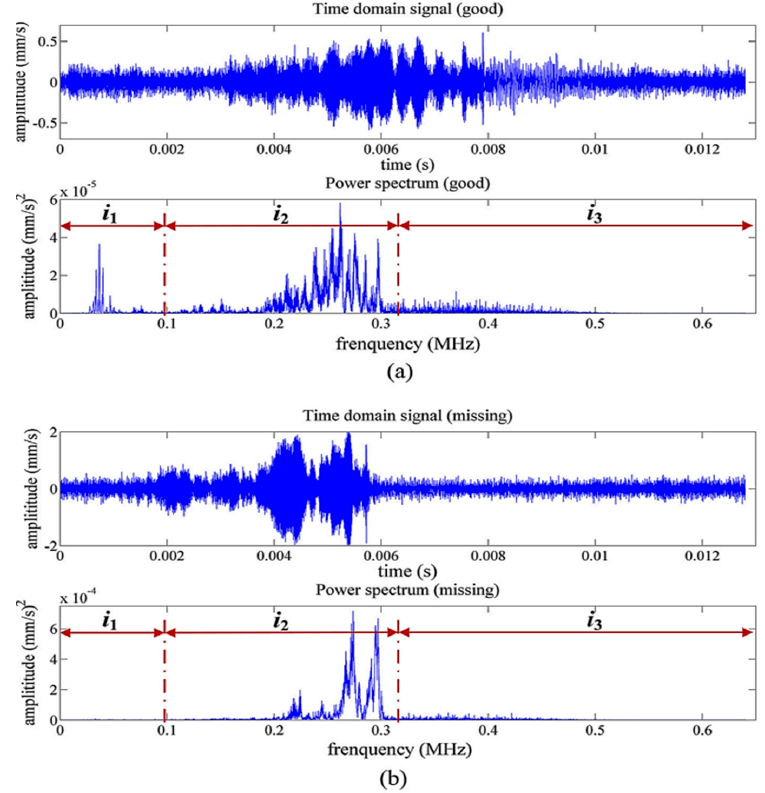
Figure 11. Representative SAW responses in the time and frequency domains obtained from ( a ) an intact flip chip and ( b ) a flip chip with a missing solder bump [82].